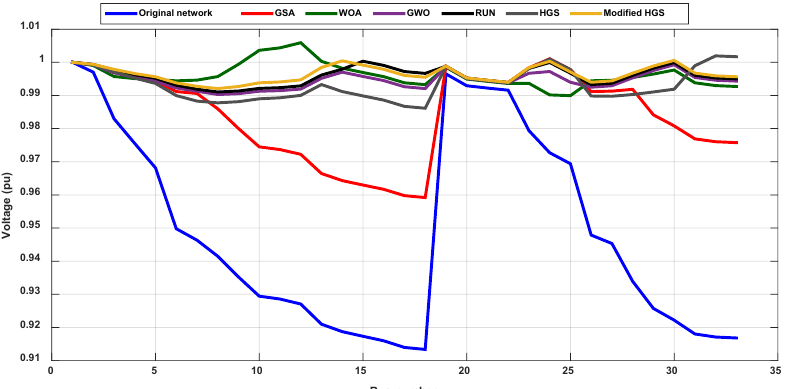
Figure 5. IEEE 33-bus network voltage profiles with and without BDGs.